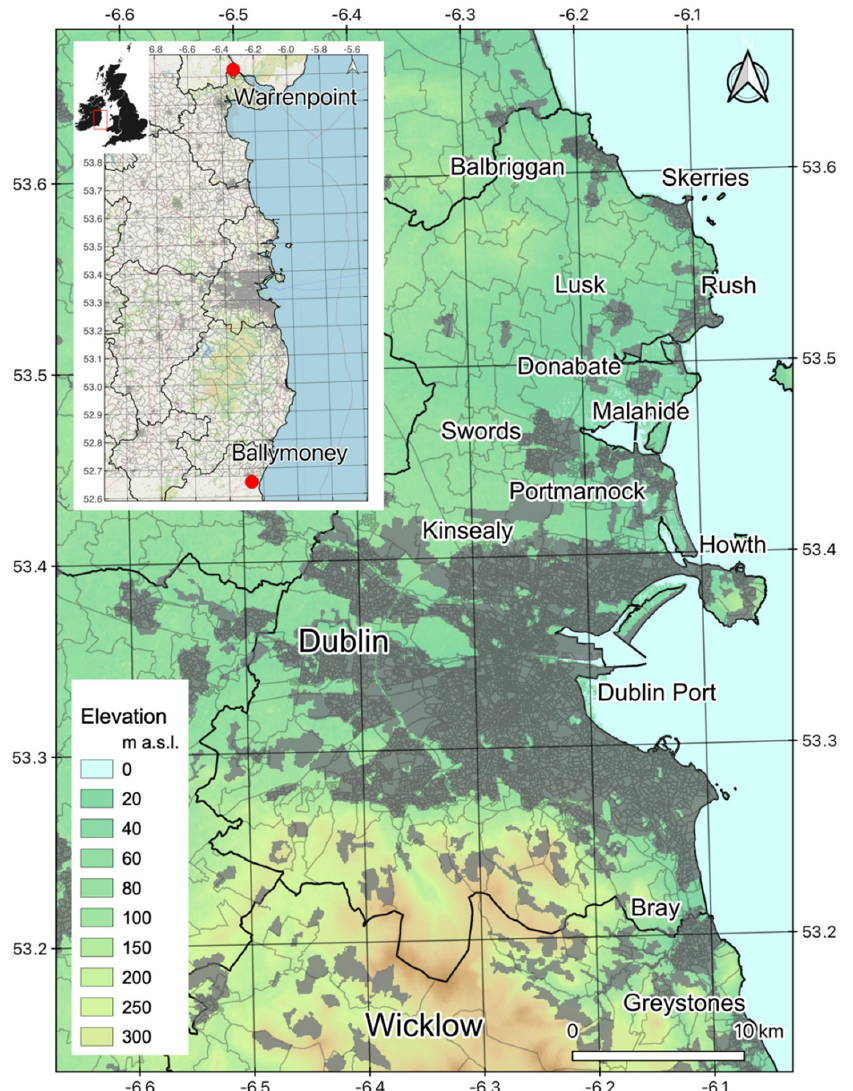
Figure 1. Study area. Small areas (SAs) are delimited in grey, urbanized areas are in dark grey; m a.s.l.: metres above sea level. The two boundaries (Warrenpoint: 54 ◦ 1 (cid:48) N, 6 ◦ 25 (cid:48) W and Ballymoney: 52 ◦ 68 (cid:48) N, 6 ◦ 22 (cid:48) W) for the coastal inundation model are shown in the upper left